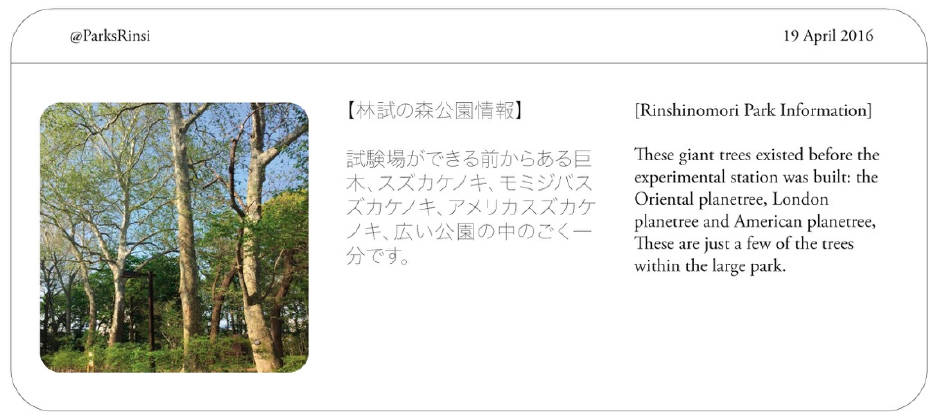
Figure 2. Analysis example. Original tweet in Japanese, English translation and categories.